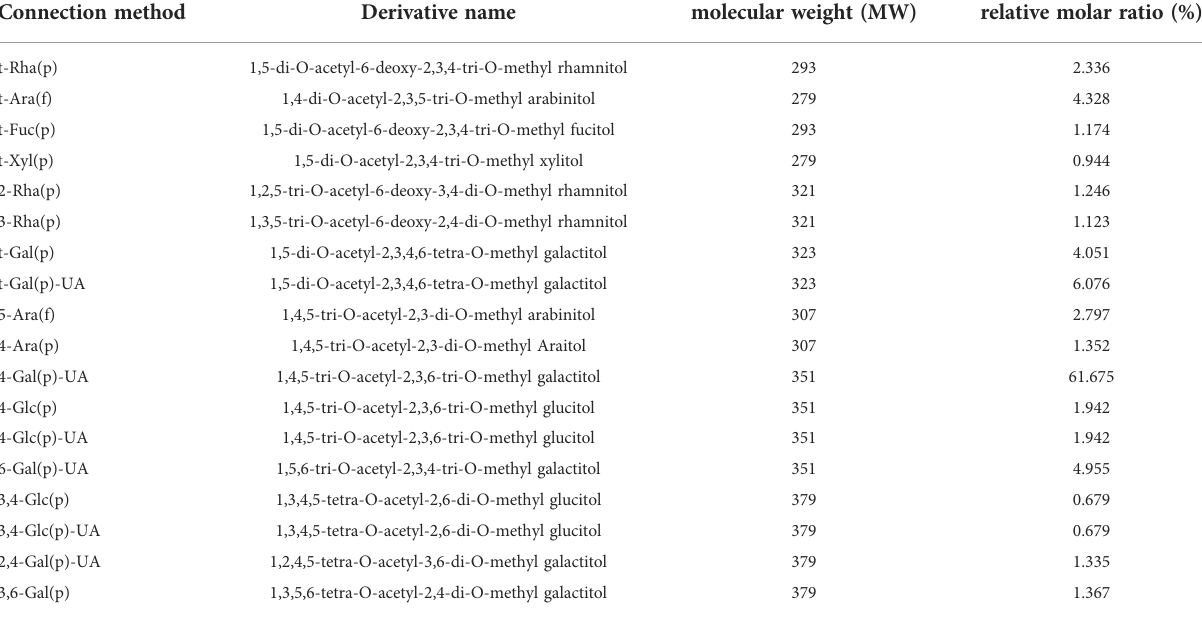
TABLE 2 The sugar residue connection mode of